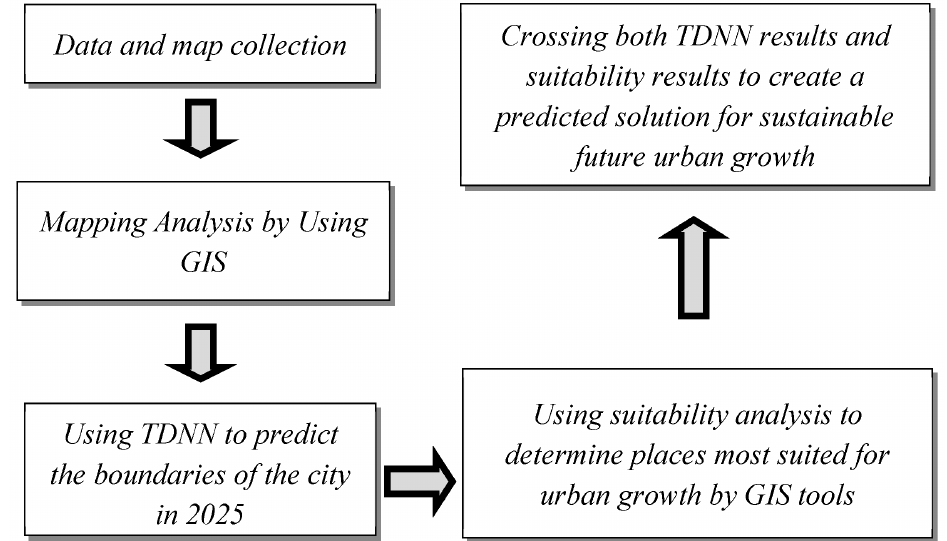
Figure 3. General structure of the proposed framework based on Time Delay Neural Network (TDNN).